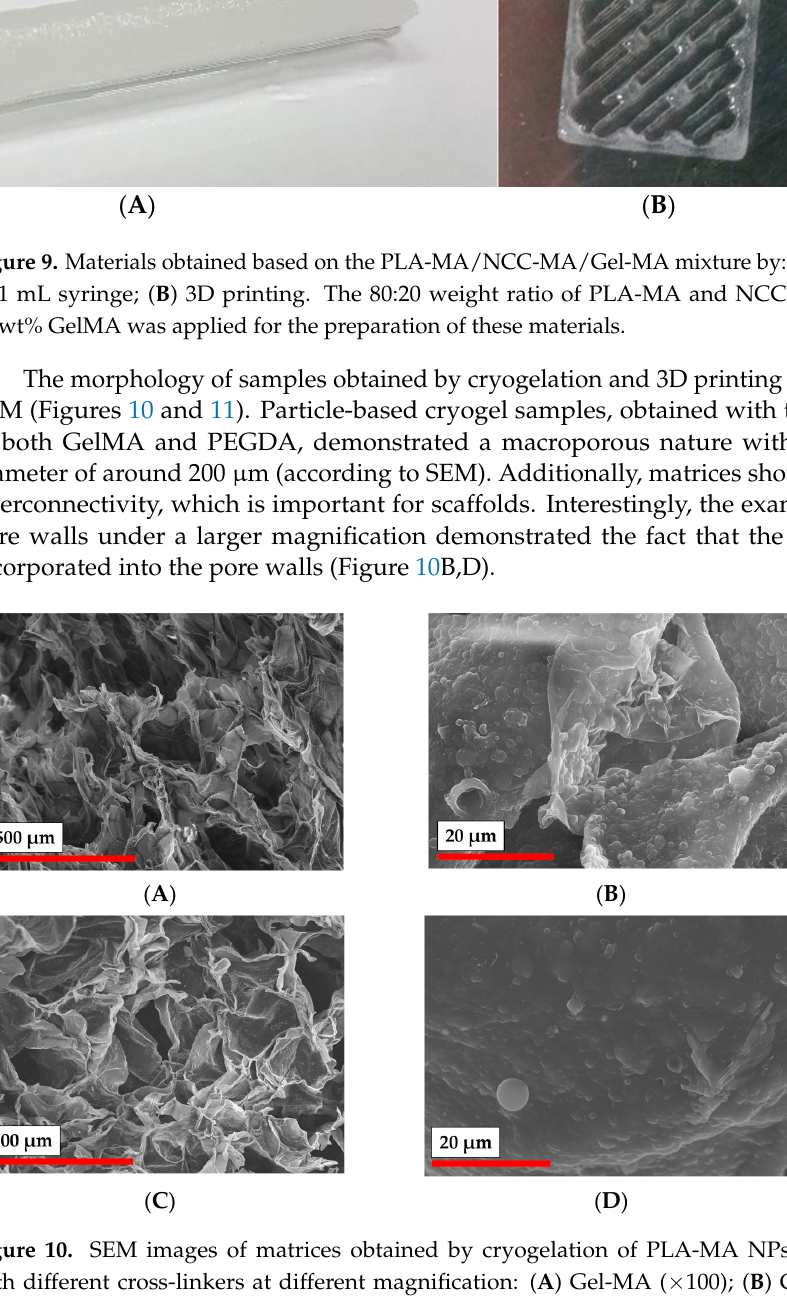
Figure 9. Materials obtained based on the PLA-MA/NCC-MA/Gel-MA mixture by: ( A ) cryogelation in 1 mL syringe; ( B ) 3D printing. The 80:20 weight ratio of PLA-MA and NCC-MA along with 20 wt% GelMA was applied for the preparation of these materials.